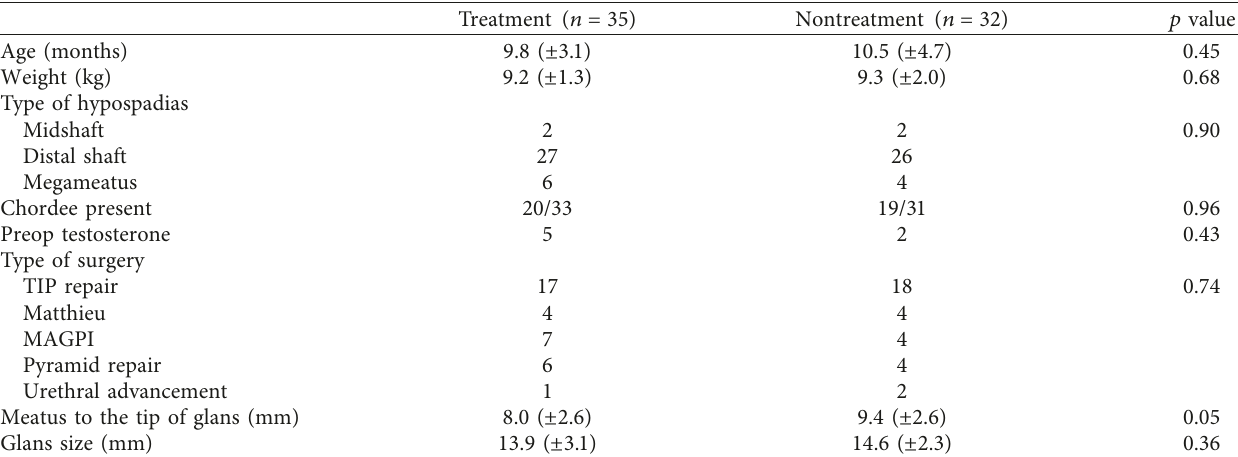
Figure 1: Study design. ∗ 3 patients withdrawn after enrolling in the study:1 with proximal hypospadias on reexam at the time of surgery and 2 patients due to lack of pharmacy support to dispense the study drug if randomized to the treatment group. ^ The patient excluded from further analysis due to bacteriuria at Table 1: Patient and hypospadias characteristics and repair type in treatment and nontreatment groups.